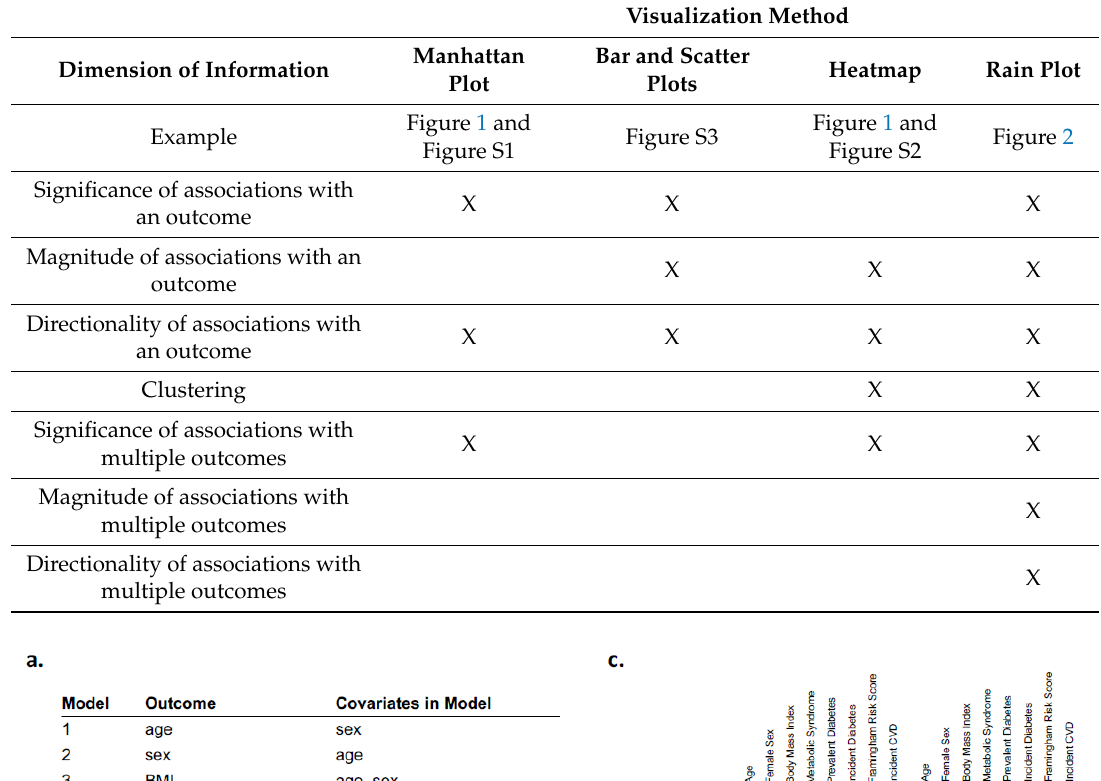
Table 1. Dimension of information o ff ered by di ff erent visualization methods.